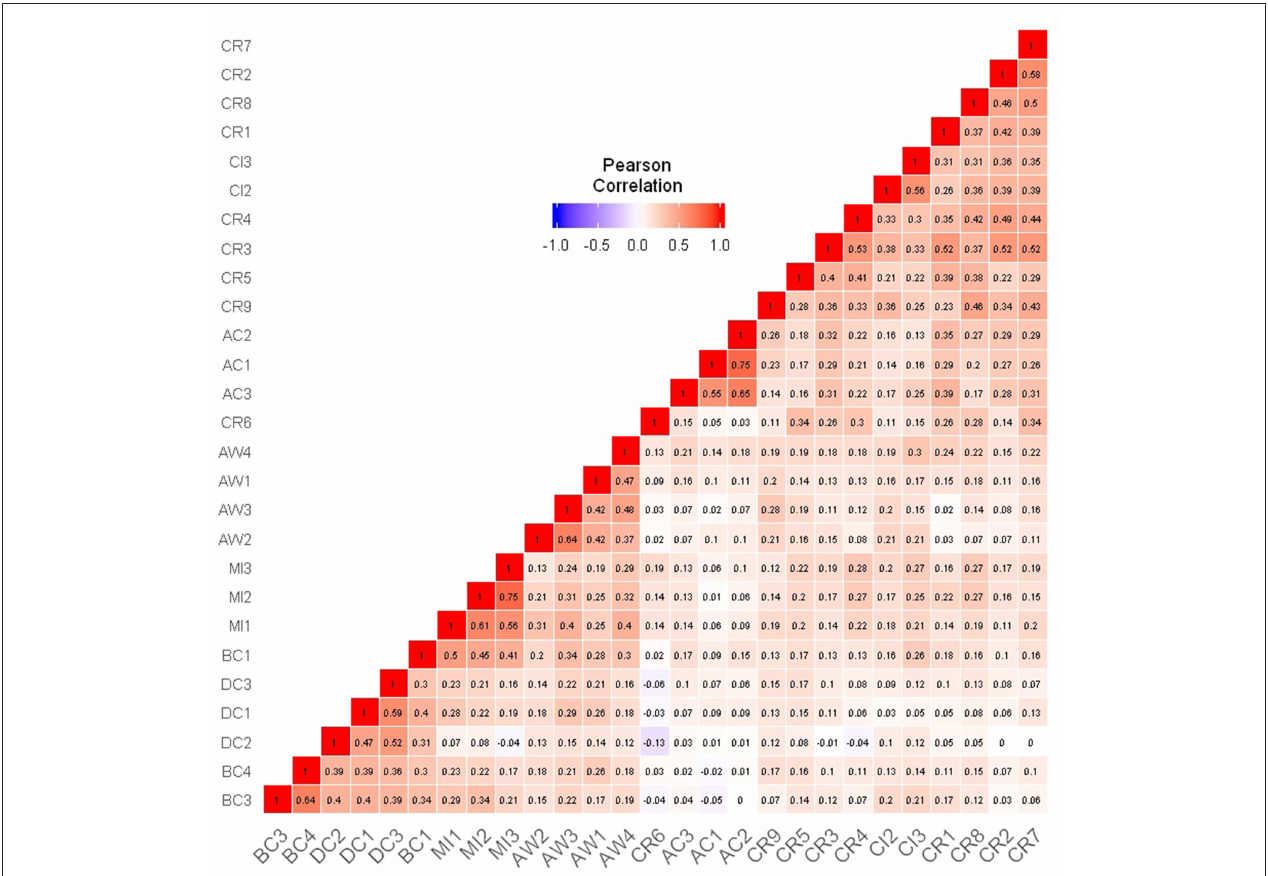
FIGURE 3 | Inter-item correlations for LVSEM.